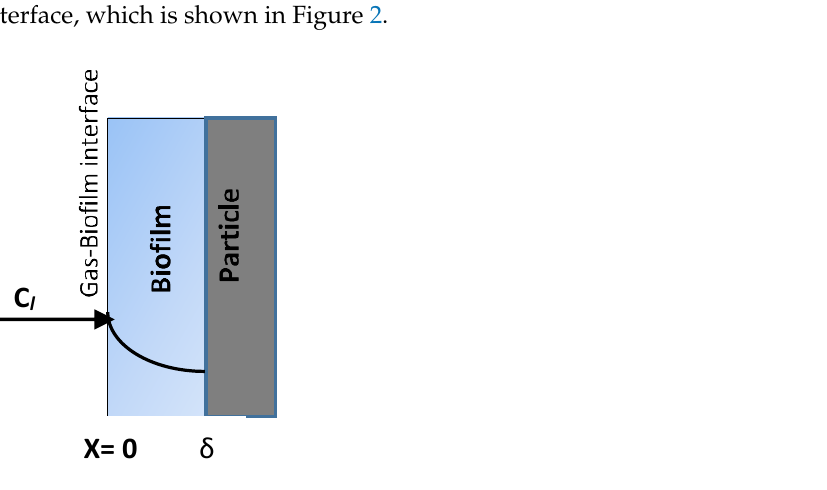
Figure 2. The diagram shows the diffusion of a pollutant into the biofilm at the gas–biofilm interface.